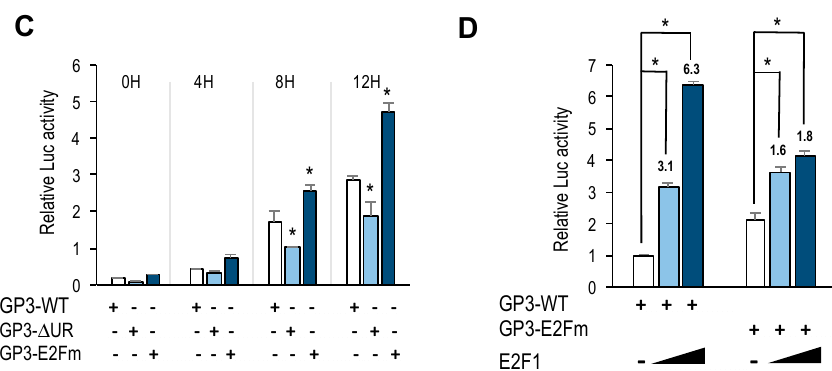
Figure 4. E2F binding motifs function as negative and positive regulatory elements. ( A ) Promoter-luciferase constructs of GOLPH3 and its derivatives. Mutant motifs are depicted with a white cross. ( B ) Asynchronous U2OS cells were transfected with the indicated luciferase reporter constructs along with pRL-TK and various amounts of a plasmid expressing E2F1 (50 ng, 150 ng, 250 ng) per well in a 12-well plate. Values are represented as luciferase activities relative to pGP3-WT activity of cells transfected with empty pCMV control. ( C ) U2OS cells were transfected with the indicated reporter constructs along with pRL-TK and synchronized in mitosis. Subsequently, cells were released into the cell cycle and luciferase values were calculated as relative values of firefly luciferase activities relative to Renilla activities in each sample. ( D ) Asynchronous U2OS cells were transfected with the indicated reporter constructs and various amounts of a plasmid expressing E2F1 (50 ng, 250 ng). Values are represented as luciferase activities relative to pGP3-WT activity of cells transfected with empty pCMV control. Shown are the results of a representative experiment of two independent experiments. *, p < 0.05.